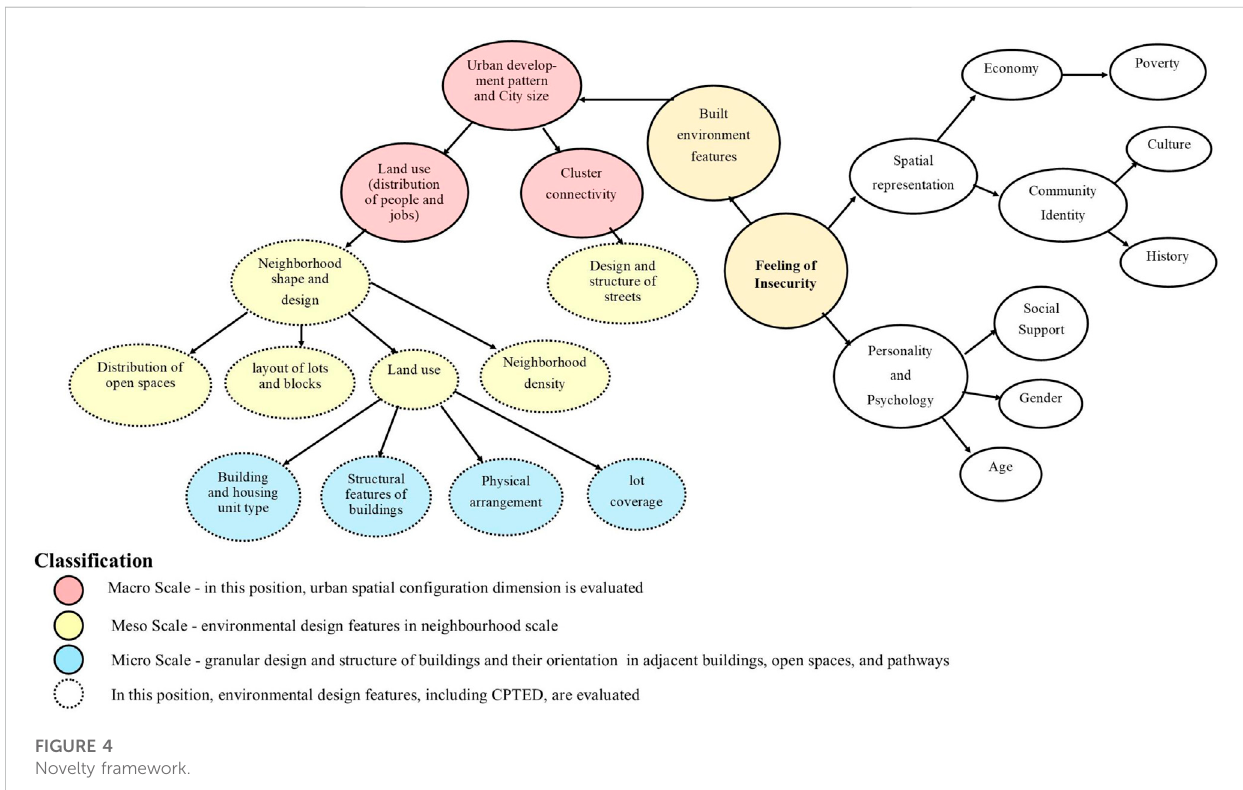
FIGURE 4 Novelty